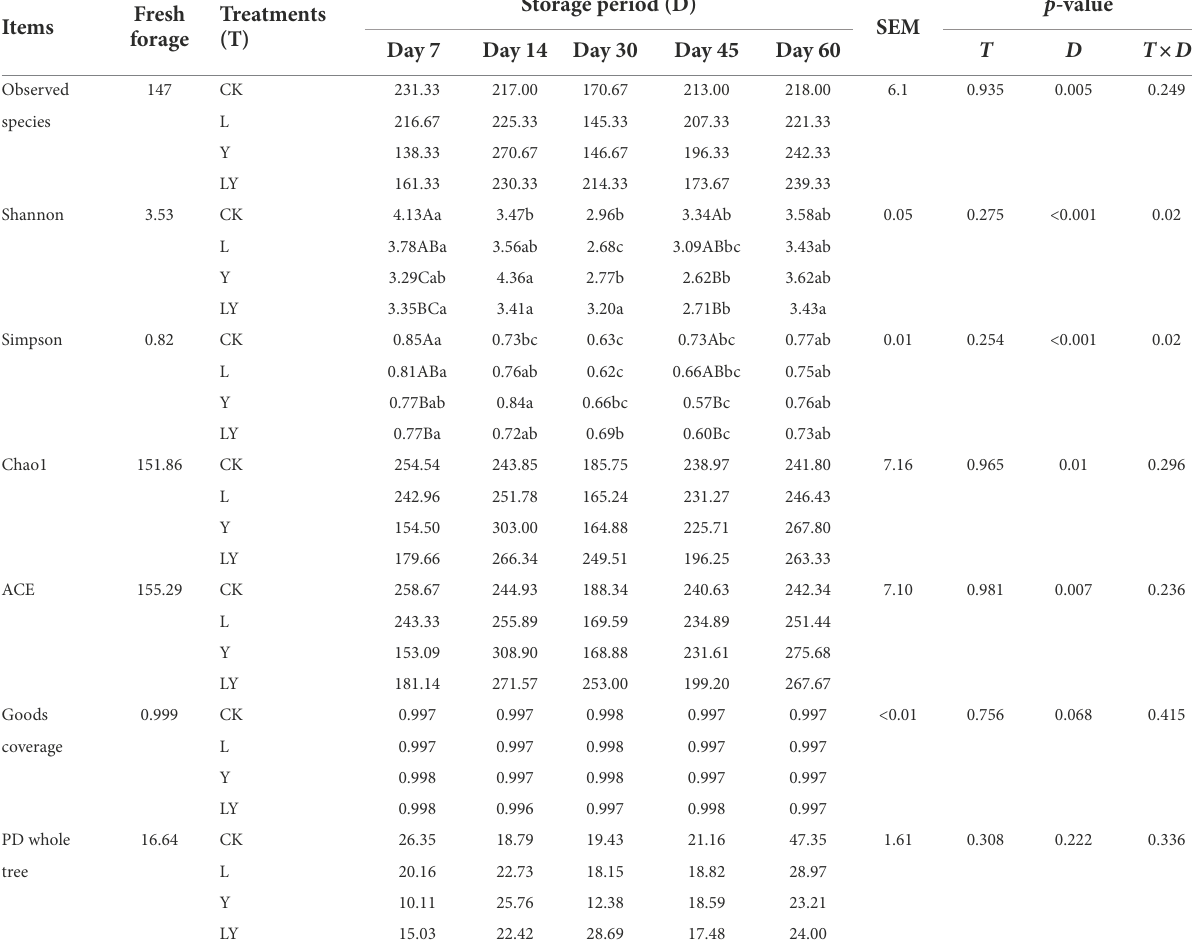
TABLE 4 Bacterial alpha diversity of cellulase-treated Pennisetum sinese (CTPS) during anaerobic storage.